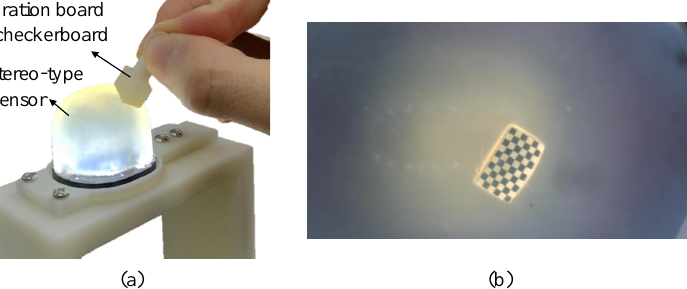
Figure 5. The platform for ground truth 3D points collection. ( a ) The 3D CNC linear guide with GelStereo-type sensors. ( b ) The left and right tactile image pairs when the probe presses on the sensor surface. The black dot on the probe tip can be clearly seen in the images. ( c ) The blob detection results of ( b ) are shown with a red dot on the image. The red tuples indicate the pixel positions.